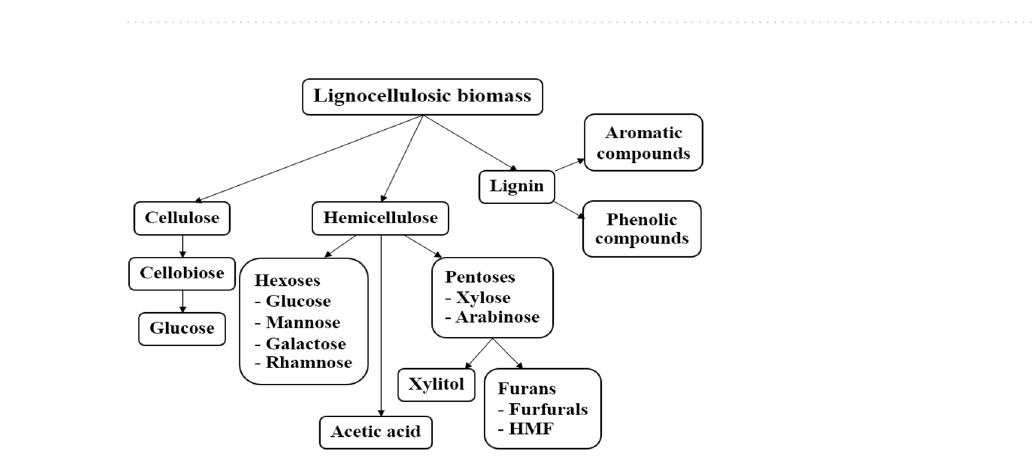
Figure 11. Proposed simplified-diagram of monosaccharide production from hemicellulose degradation of the rice straw waste.